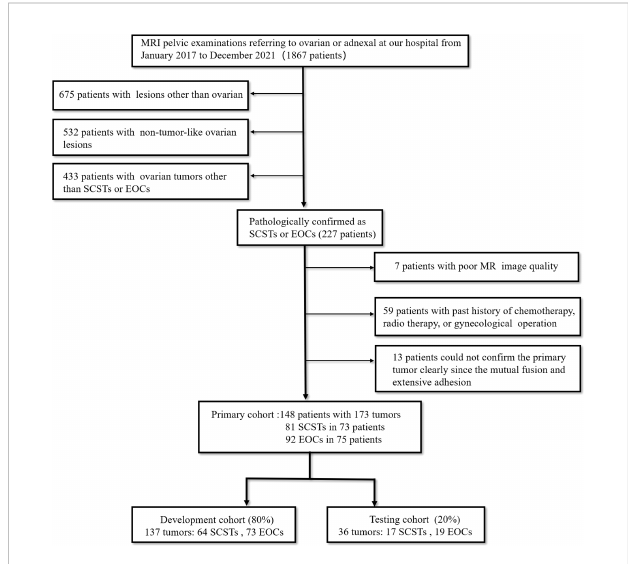
FIGURE 1 Flowchart for the patient selection process in this study.